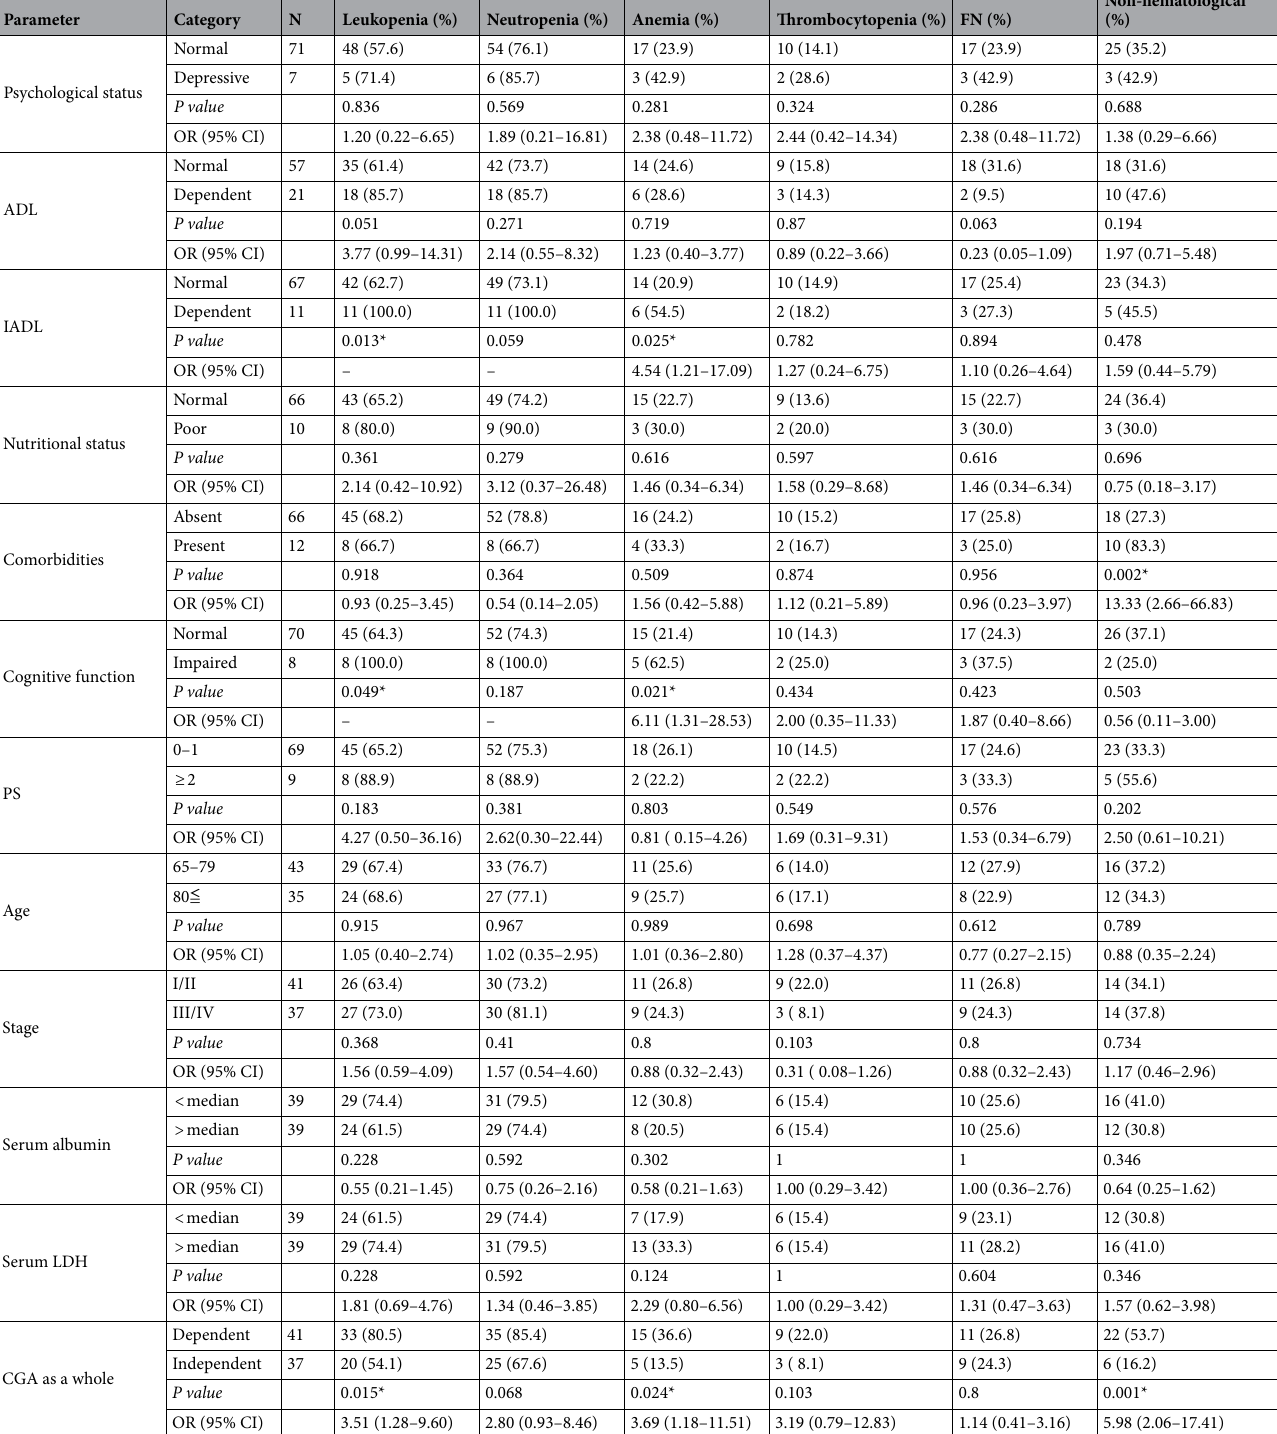
Table 5. Univariate analyses for CGA domains or clinical factors associated with the occurrence of toxicities (grade 3–4). ADL activity of daily living, CGA comprehensive geriatric assessment, CI, confidence interval, FN febrile neutropenia, IADL instrumental ADL, * indicates a significant difference; PS , performance status, LDH , lactate dehydrogenase, OR , odds ratio, P -value, Simple logistic regression analysis or Fisher’s exact test if simple logistic regression analysis is not appropriate due to quasi-complete